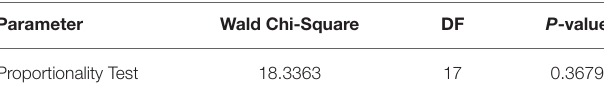
TABLE 5 | Test of proportional hazard assumption for the multivariate Cox regression model used in Table 2 . Parameter Wald Chi-Square DF P -value Proportionality